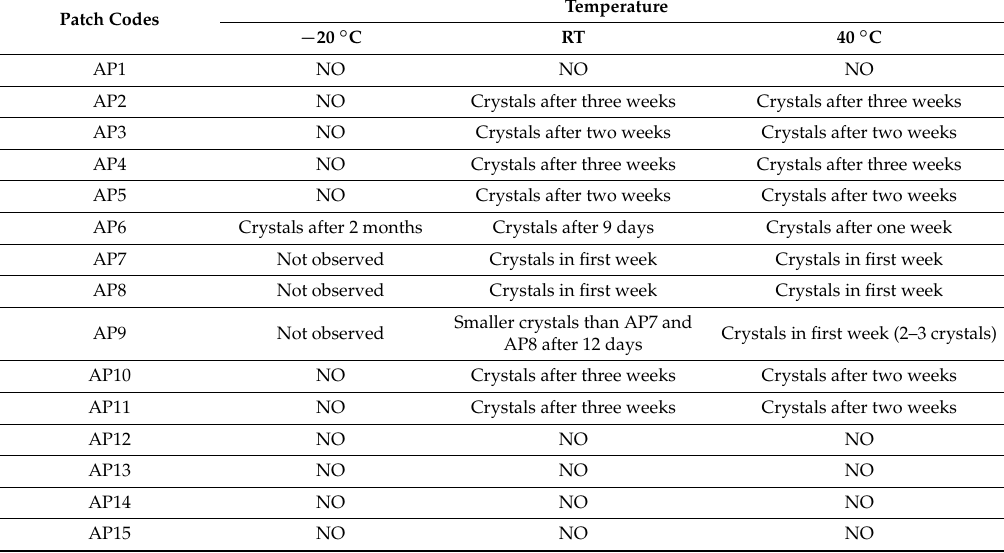
Table 4. Microscopy observations of acrylate based TAF transdermal patch formulations up to 6